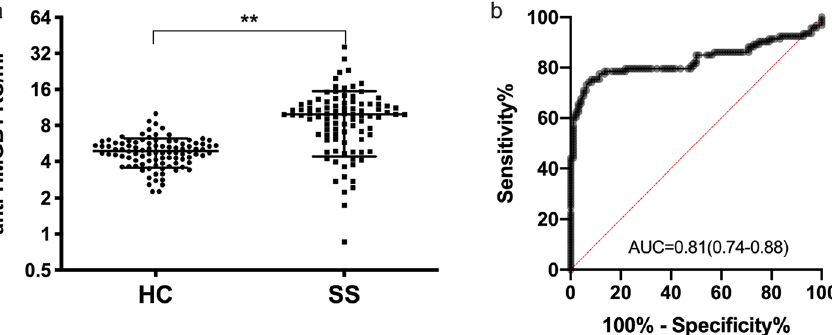
Figure 1. Serum anti-HMGB1 antibody in SS patients. ( a ) ELISA results showed that the anti-HMGB1 antibody were 4.9 ± 1.4 RU/ml and 9.96 ± 5.55 RU/ml in healthy controls and SS patients, respectively. The comparison between the healthy controls and SS patients was tested by Student’s t test. ** represents P < 0.01. ( b ) ROC curve analysis was performed to calculate the optimal cutoff value of anti-HMGB1 antibodies in the diagnosis of SS. When taking 8 RU/ml as the cut-off value, and the sensitivity and specificity were 64.5% and 96.9% respectively, and the AUC was 0.83 (95% confidence interval: 0.76–0.90).